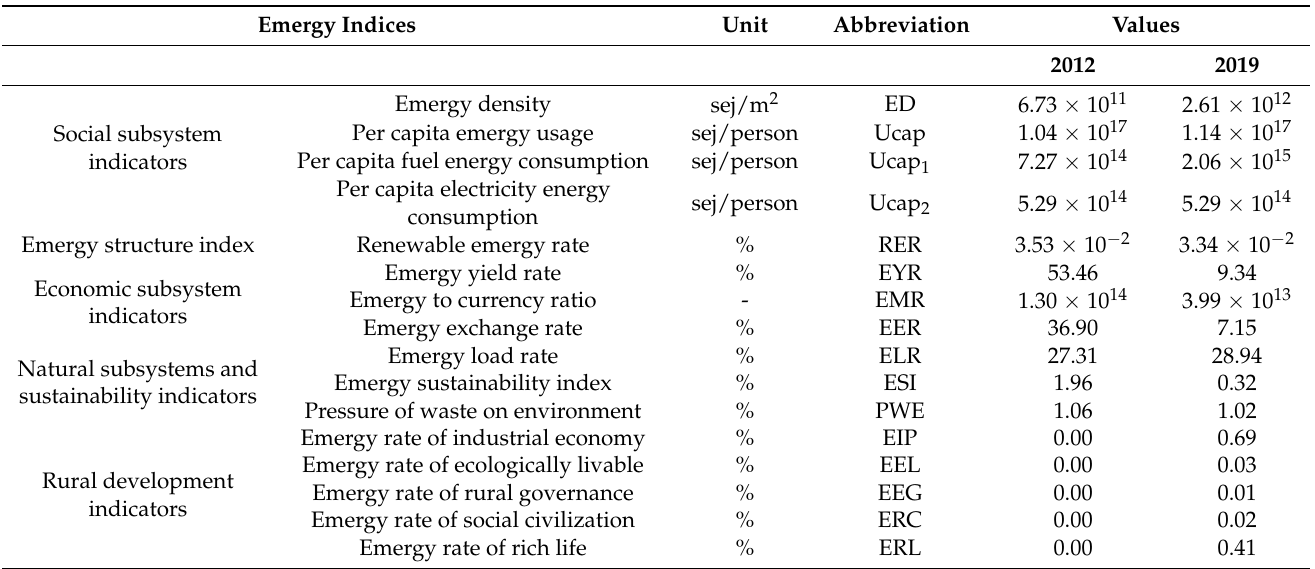
Figure 4. Resources and rate of change of Chehe Village in the year of 2012 and 2019. Renewable emergy ratio decreased from 0.04 in 2012 to 0.03 in 2019, which could be a result of the increase of nonreneable resources or purchased inputs. The emergy indices results were listed in Table 3. Table 3. Emergy indices of Chehe